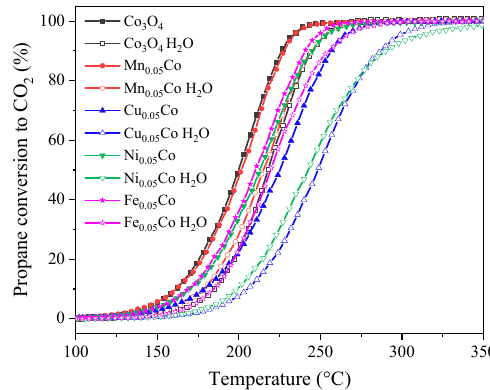
Figure 9. Variation of the propane conversion with the reaction temperature during the cooling run over the Co 3 O 4 and M 0.05 Co catalysts in the absence and presence of 4.4 vol.% water.